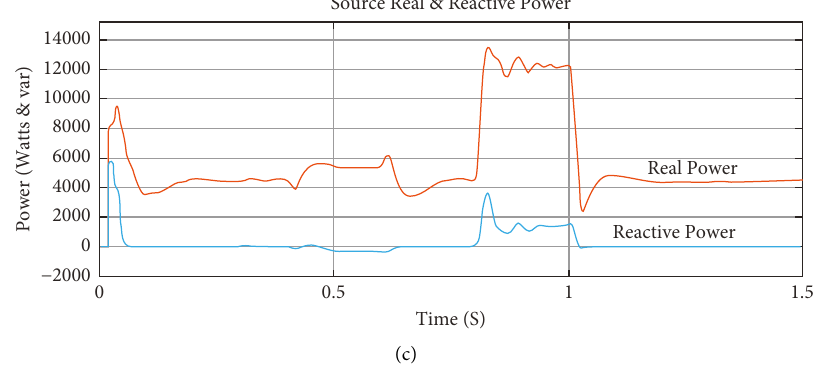
Figure 7: (a)DC link voltage, (b) MMC output voltage, and (c) source side real and reactive power.